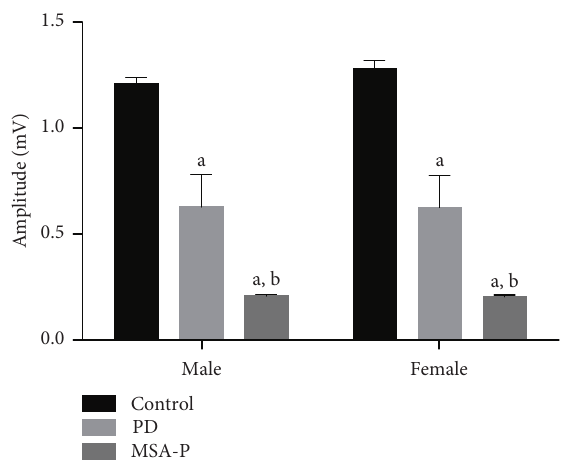
Figure 3: Comparison of BCR amplitude of the PD group, MSA-P group, and control group. a p < 0 . 05 compared to control. b p < 0 . 05 compared to PD.